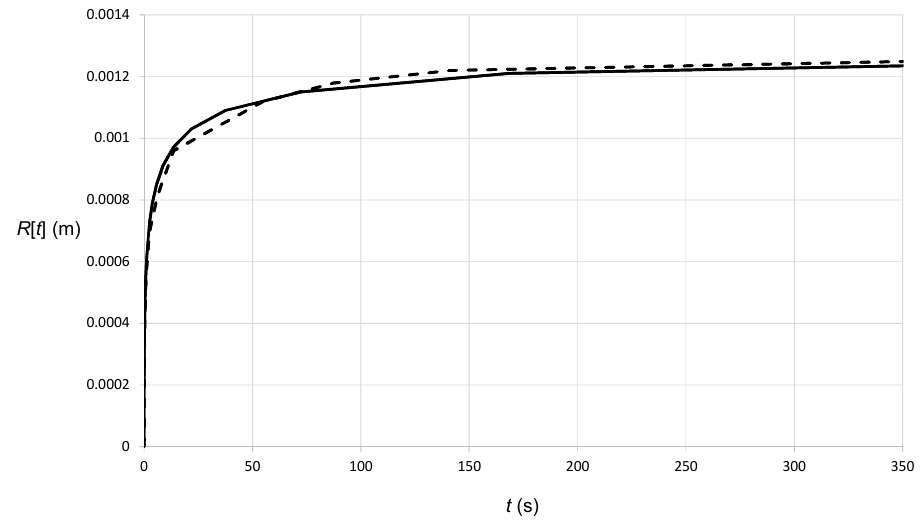
Figure 3. Heat transfer in a homogeneous, semi-infinite material with a continuous heat release at a single point. The curves show the radius (semi-spherical interface) where the temperature has the constant value T melt , as a function of time. The solid curve is the analytical solution (Equation (12)), and the dashed curve is the numerical solution obtained using the finite element analysis (ANSYS [38]).